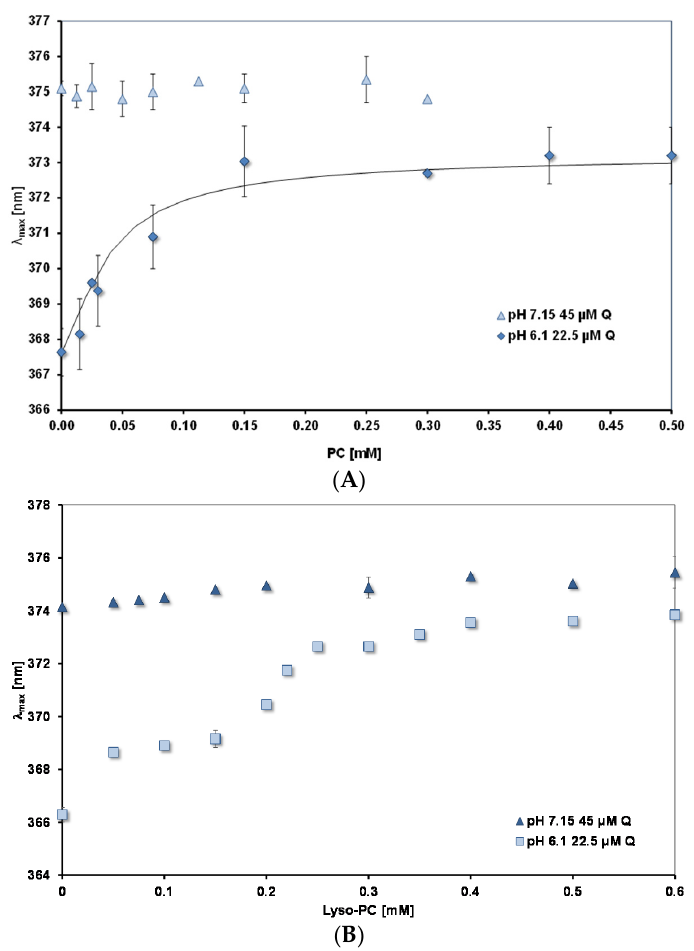
Figure 6. λ max for peak B as a function of lipid concentration. ( A ) PC; ( B ) Lyso-PC. The continuous black line in ( A ) is calculated from a binding constant of 45 mM − 1 .